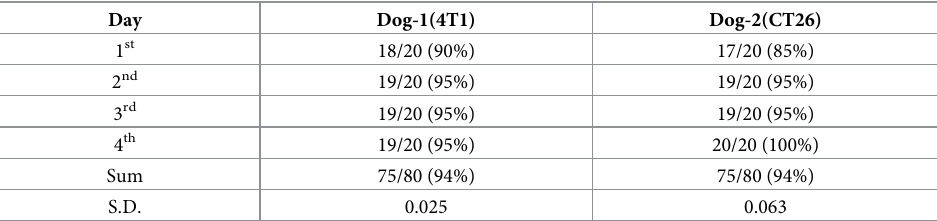
Table 1. Detection accuracy for the familiar cancer